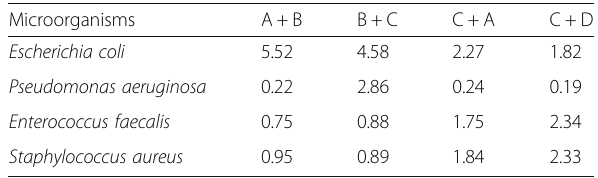
Table 2 Fractional inhibitory concentration indexes of the 1:1 combinations of the selected